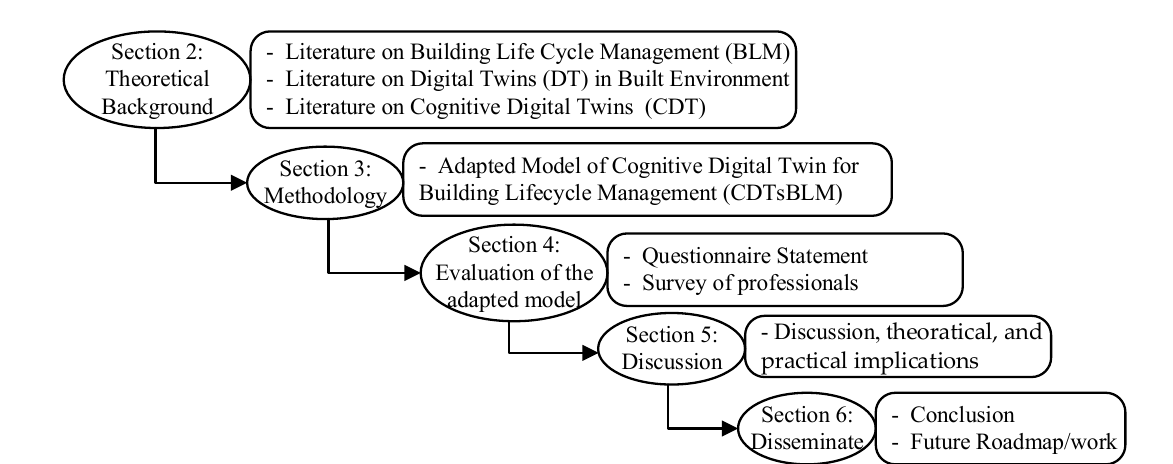
Figure 1. Research framework of the adapted model of Cognitive Digital Twins for Building Lifecycle Management.